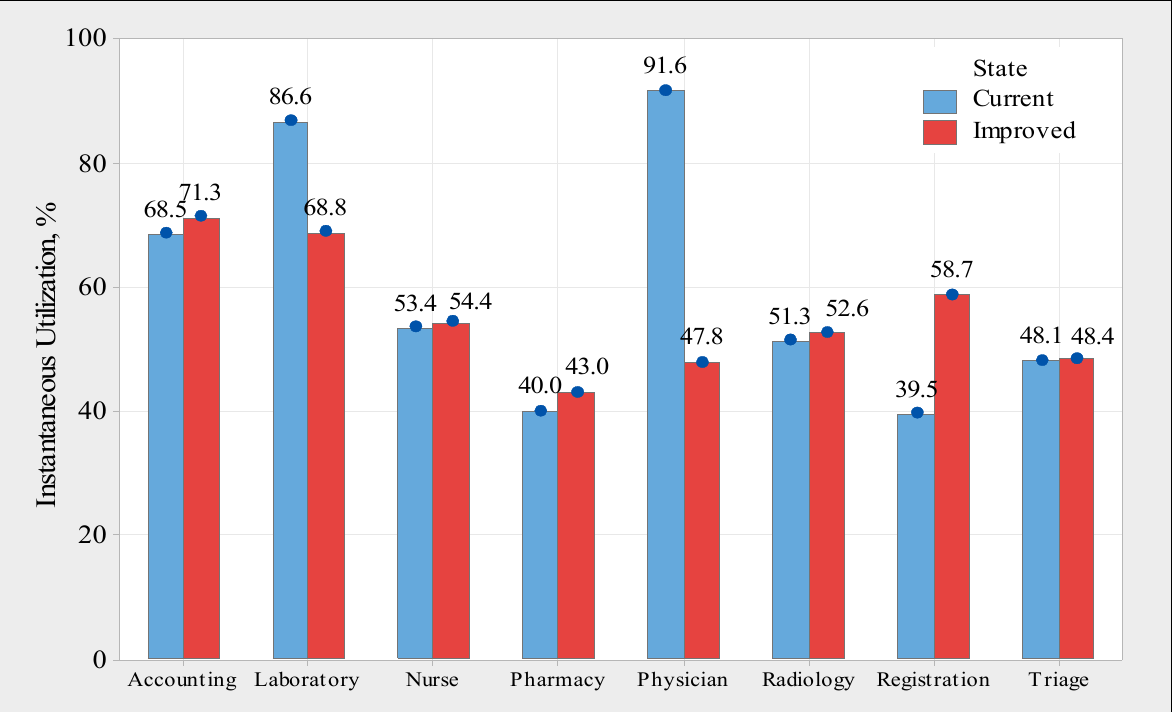
Figure 15. Comparison between the current state and improved state regarding instantaneous uti ‐ lization.